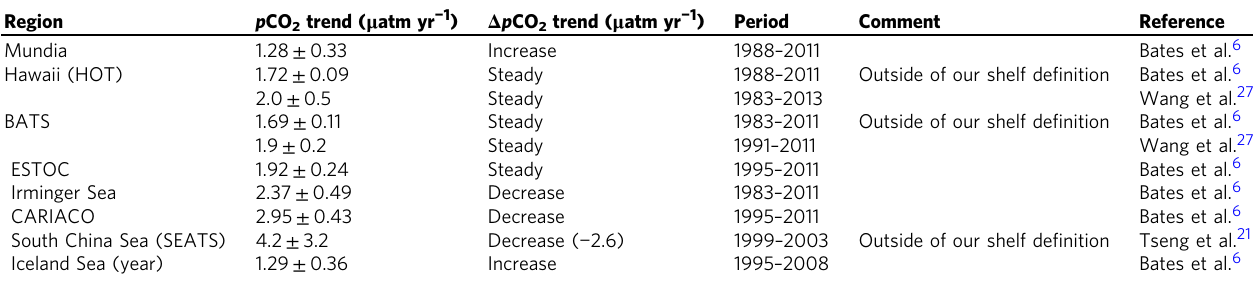
Table 1 Rates of change in p CO 2 and corresponding rate of change in Δ p CO 2 reported in the literature for coastal time series